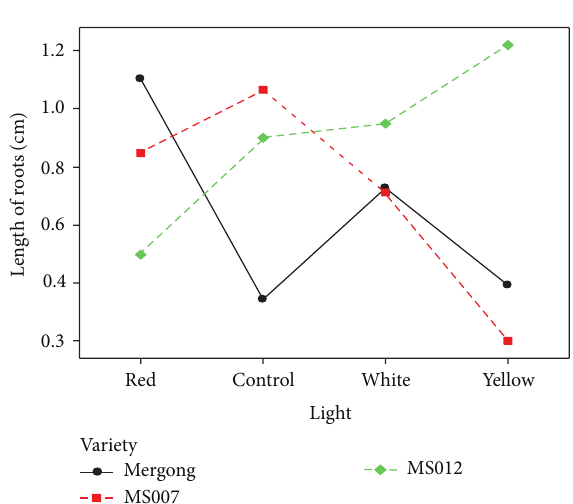
Figure 2: Interactions between varieties and light treatments in root length on day